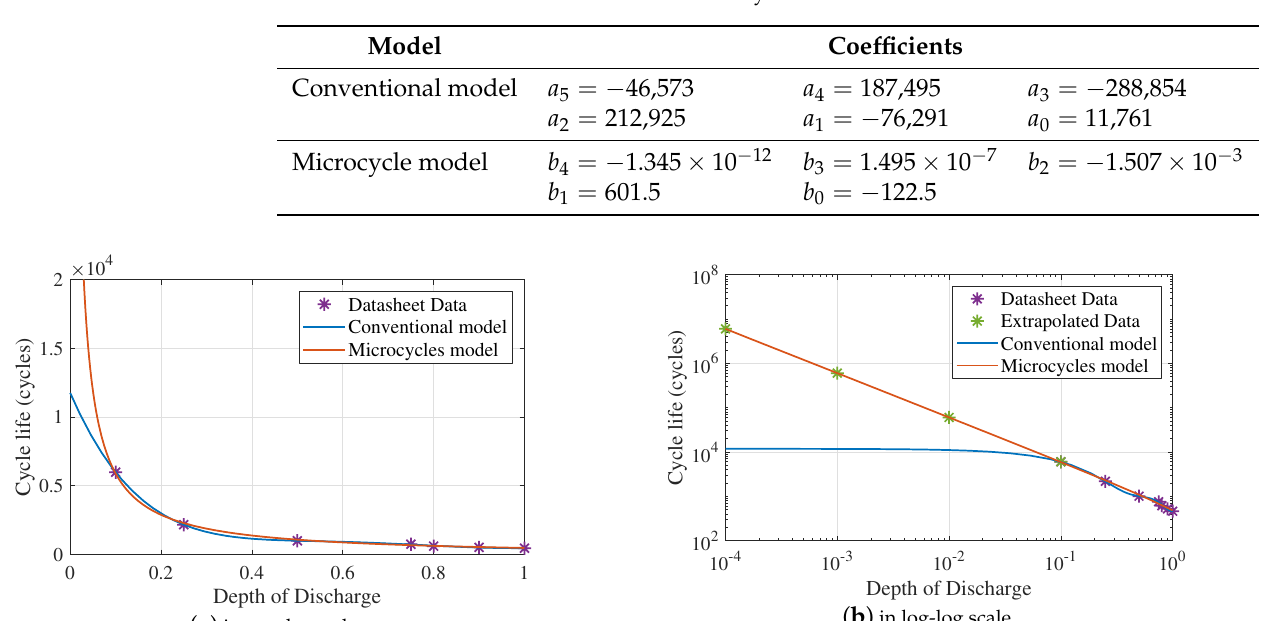
Table 1. Coefficients of conventional and microcycle models.